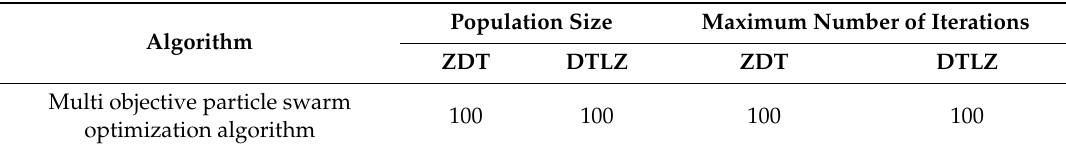
Table 2. Experimental parameter settings.